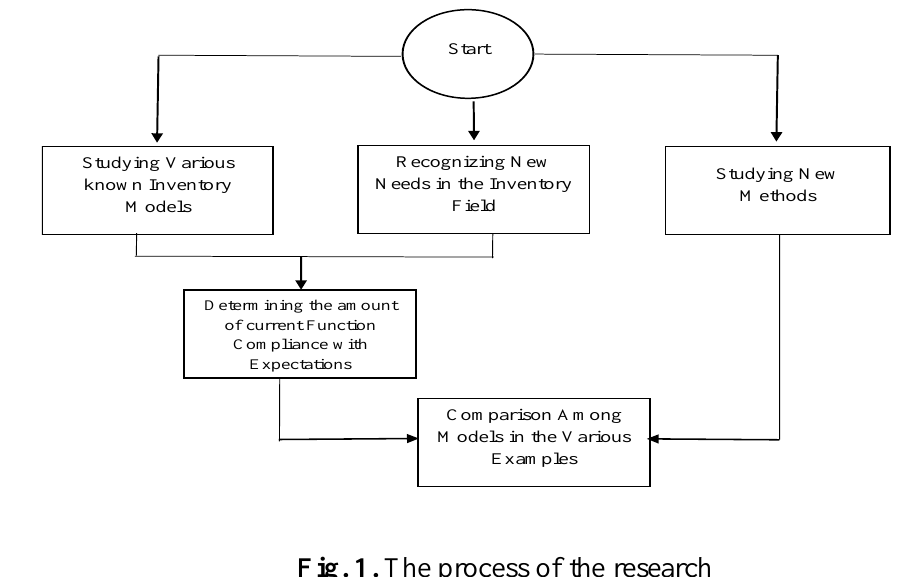
Fig. 1. The process of the